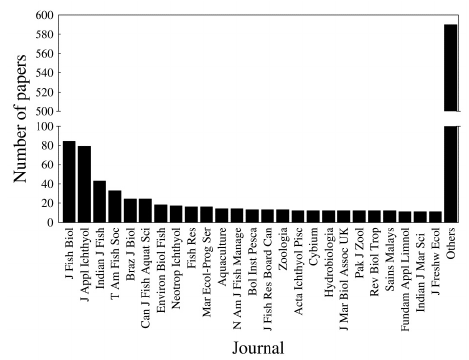
Figure 2. Number of papers published in different journals that cited ‘Le Cren, 1951’ based on a search from 1951 to December 2015.